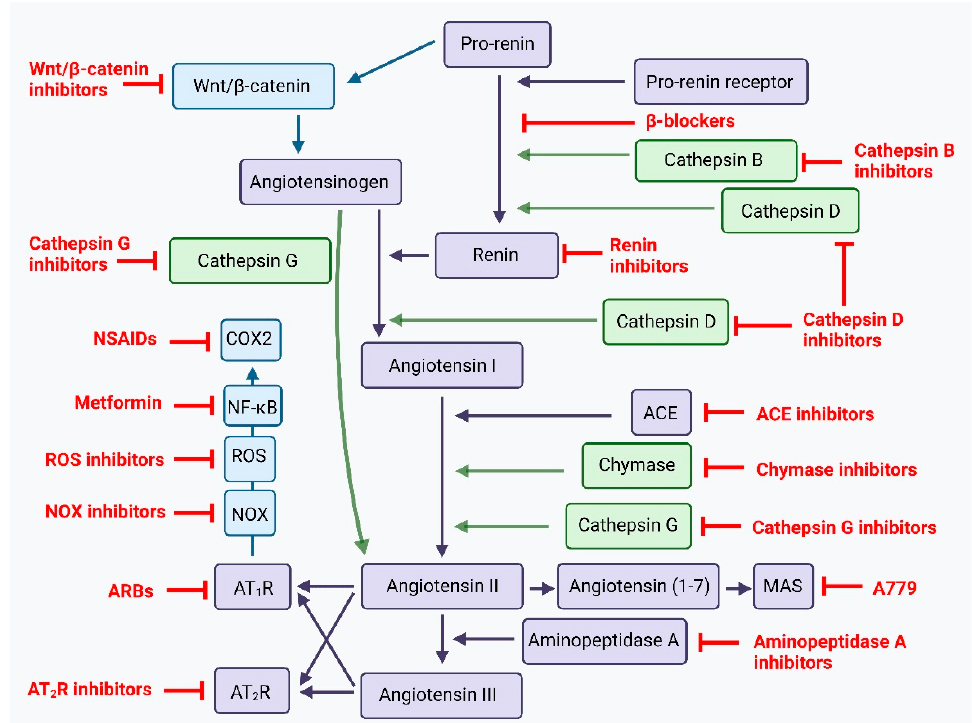
Figure 5. The renin-angiotensin system and its bypass loops and converging signaling pathways can be targeted at different points. The renin-angiotensin system (black) regulates blood pressure, stem cell differentiation, and tumor development. Bypass loops in the system involving cathepsins and chymase (green) provide redundancy, while convergent inflammatory and development signaling pathways (blue) have multiple roles and effects. Multiple points of the pathway can be targeted by specific inhibitors (red). ACE, angiotensin converting enzyme; ARBs, AT 1 R blockers; ROS, reactive oxygen species; NSAIDS, non-steroidal anti-inflammatory drugs. Adapted from Frontiers in Oncology [120]. Diagram recreated with BioRender.com, accessed on 1 November 2022.